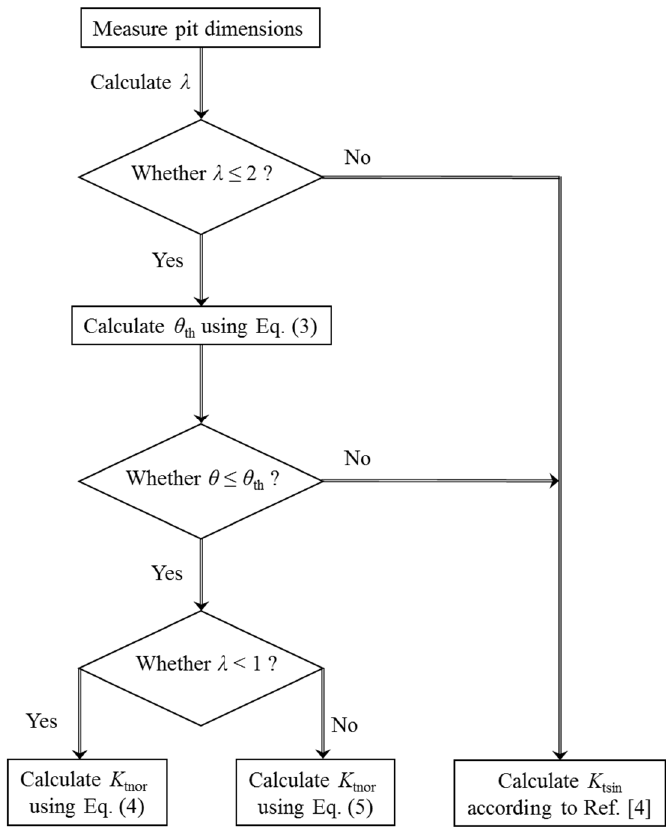
Figure 15. Flow chart for estimating the normalized SCF.